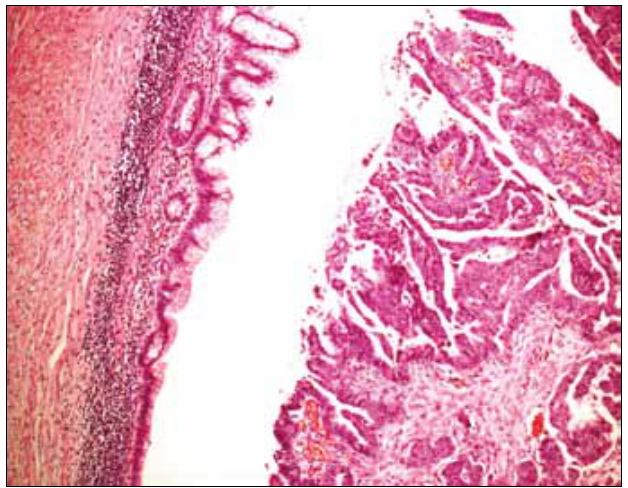
Fig. 2. Metastatic papillary serous adenocarcinoma in the